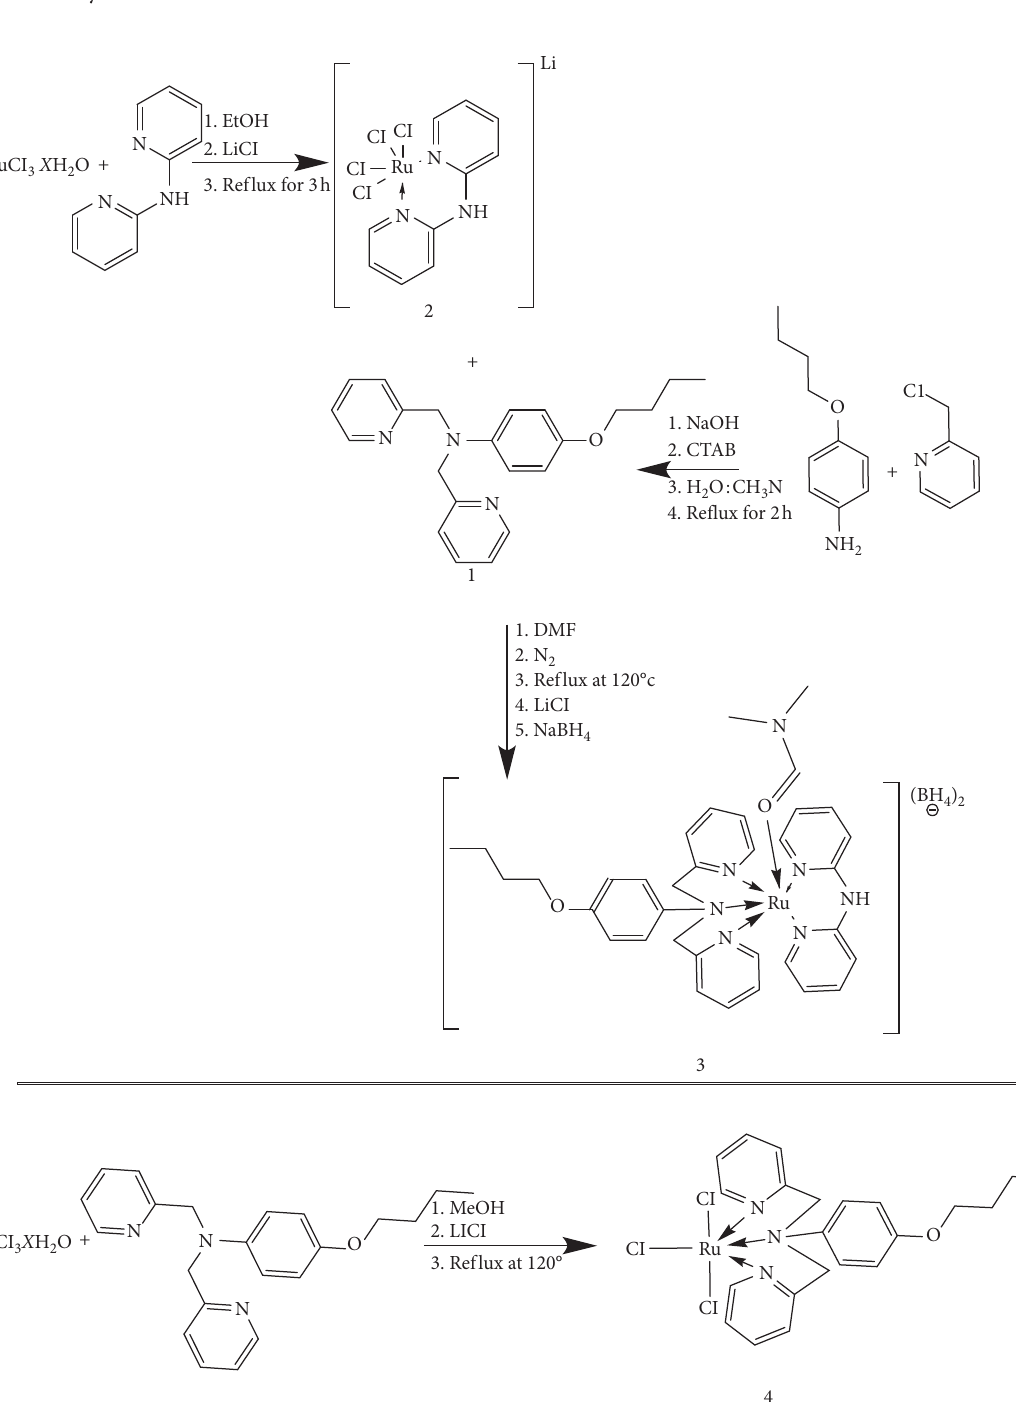
4 (DPA)] (1) , [Ru(BUT)(DMF)(DPA)](BH 4 ) 2 (3) ,